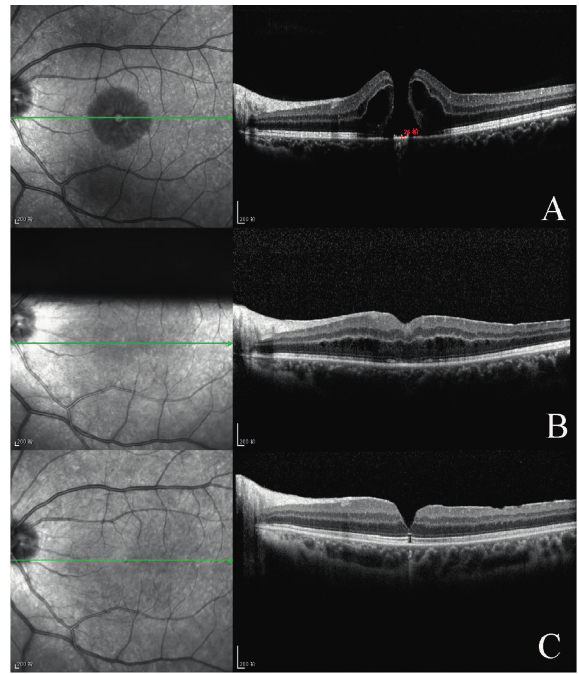
Figure 6: Case 11: a 45-year-old male patient with macular holes closed by vitrectomy combined with ILM peeling and C3F8 tamponade. The patient’s left eye was damaged by a laser. His BCVA was 20/200. at initial and improved 20/63 after surgery. (a) Preoperative OCTimage showing FTMH with intraretinal cyst. (b) OCTimage 2 weeks postoperative showing the closed hole and intraretinal edema. (c) OCTimage 4 months postoperative showing closed hole, but ellipsoid band had not regained integrity. His BCVA was now 20/63.